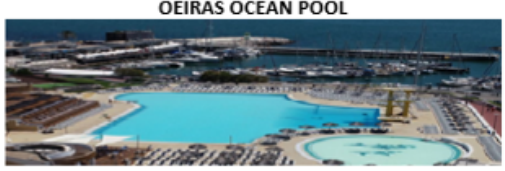
Figure 11. Oceanic pool of